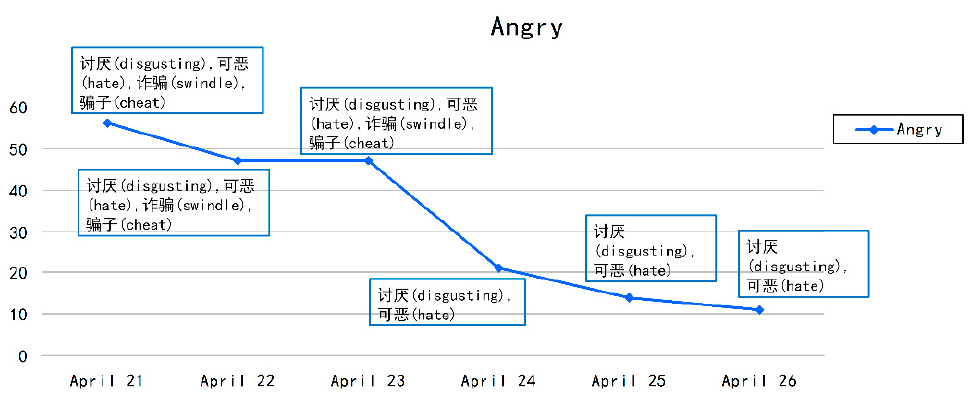
Figure 11. Sequence diagram of anger.